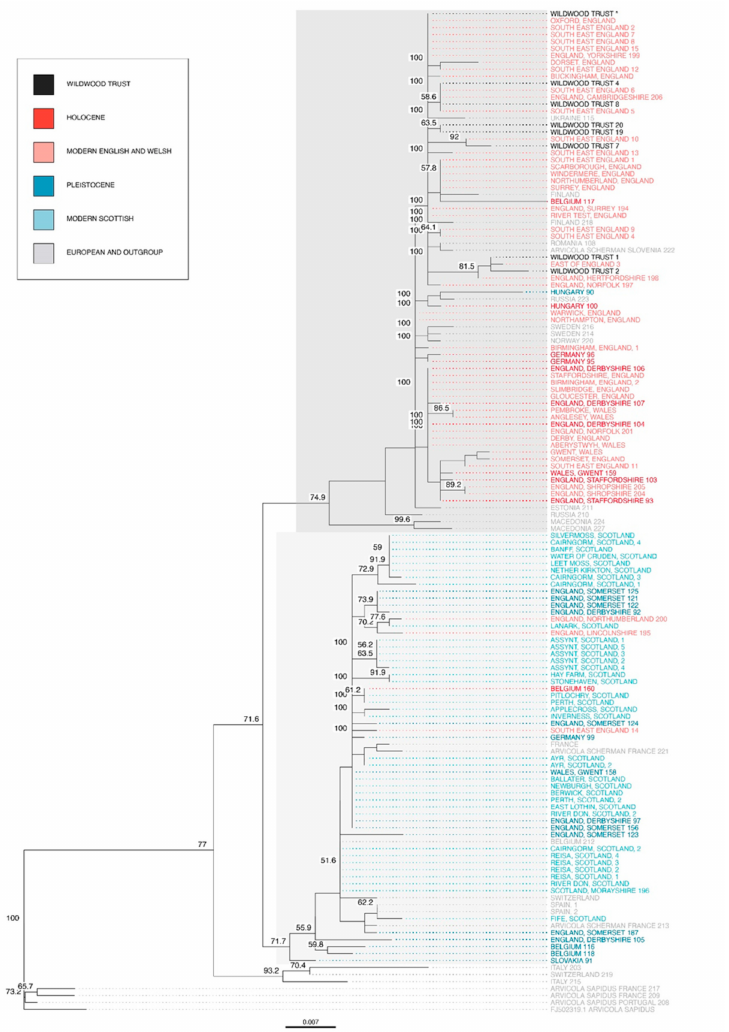
Figure 4. ML phylogenetic tree of sampled Arvicola individuals rooted on Arvicola sapidus . Taxon colour represents the age or location of the sample. The taxon ‘Wildwood Trust*’ contains multiple Wildwood Trust samples that formed a monophyletic group. Only bootstrap scores greater than 50% are